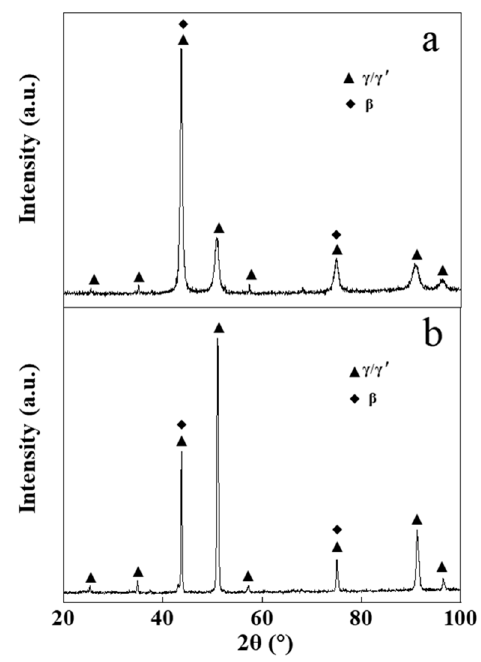
Figure 4. XRD patterns of the NiCrAlY bond coat before and after a high-current pulsed electron beam irradiation: ( a ) nonirradiated coating, ( b ) 18 J/cm 2 . a.u.—arbitrary units.